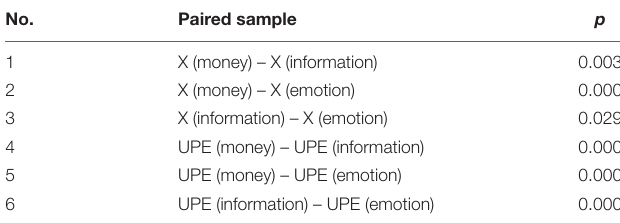
TABLE 5 | Paired sample t